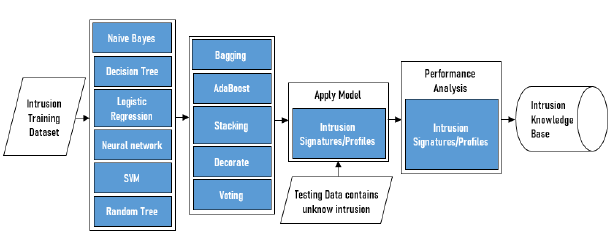
Figure 3. The DoS attacks detection model using a ensemble techniques.